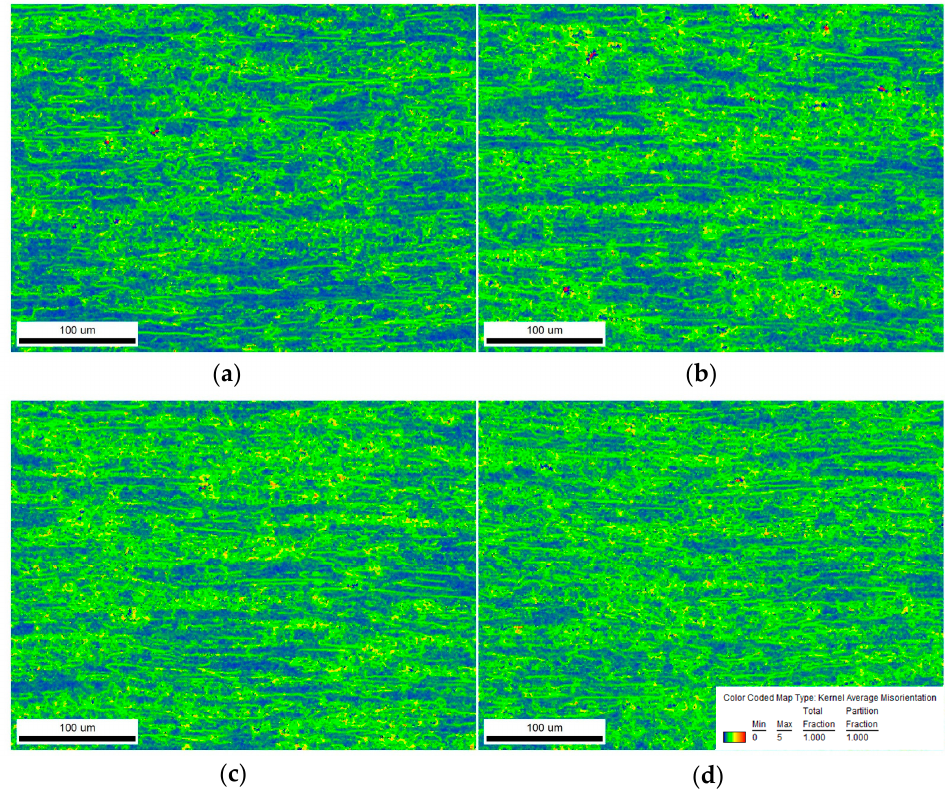
Figure 5. KAM diagrams of fractured samples at different temperatures: ( a ) 298 K; ( b ) 213 K; ( c ) 113 K; and ( d ) 20 K.